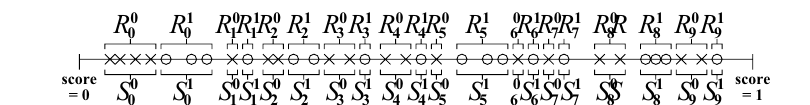
Fig. 2 The crosses (“x”) indicate the scores for subpopulation 0 while the circles (“o”) indicate the scores for subpopulation 1. The averages of the scores for subpopulation 0 for the indicated blocks of observed scores are S 0 0 , S 0 1 , ..., S 0 9 , while the averages of the scores for subpopulation 1 are S 1 0 , S 1 1 , ..., S 1 9 . The averages of the responses for subpopulation 0 corresponding to the indicated blocks of observed scores are R 0 0 , R 0 1 , ..., R 0 9 , while the averages of the responses for subpopulation 1 are R 1 0 , R 1 1 , ..., R 1 9 . The scores need not range from 0 to 1 as in the present figure, but that is a common case